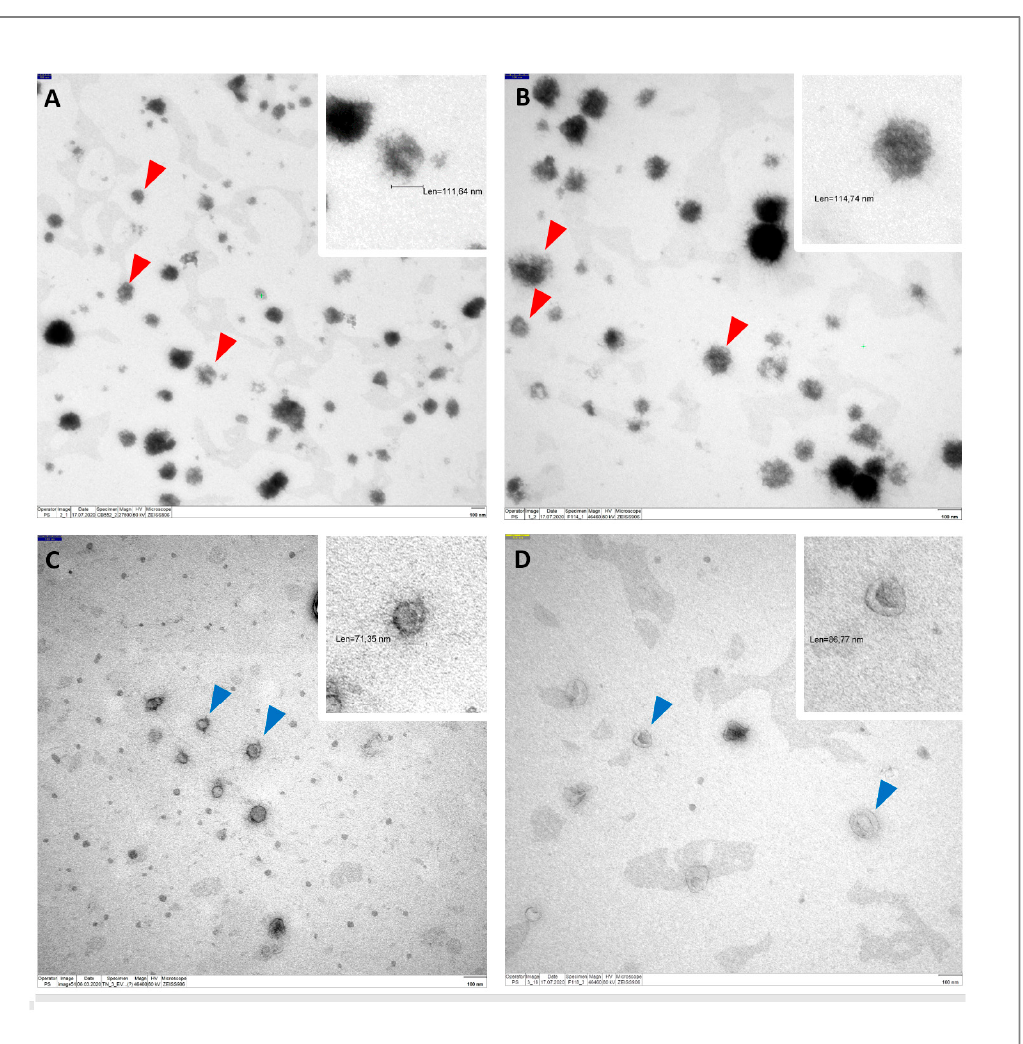
Figure 2. Particle number, protein amount and size distribution of EVs isolated from CB- and AT- MSCs. Particle concentration ( A ) and size distribution ( C ) of EV preparations were measured by nanoparticle tracking analysis. Protein content ( B ) was determined by the bicinchoninic acid assay. In ( A – C ), the results are mean values ± standard deviation (SD) obtained from four different donors per cell type.